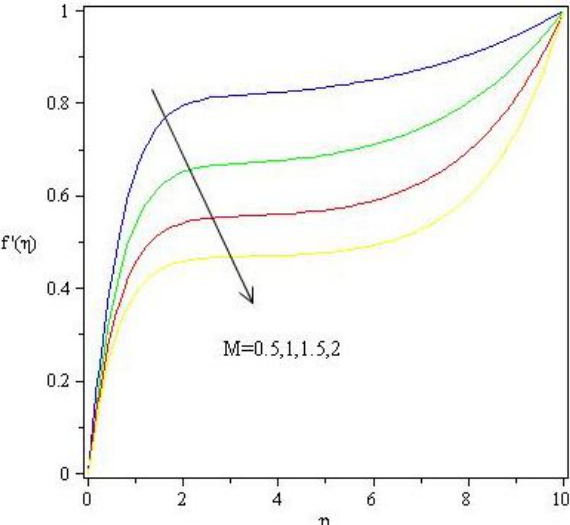
Fig. 6: Velocity profile for different values of M and n = 1.5, Pr = 1, A = 0.5, B = 0.5, p = 1